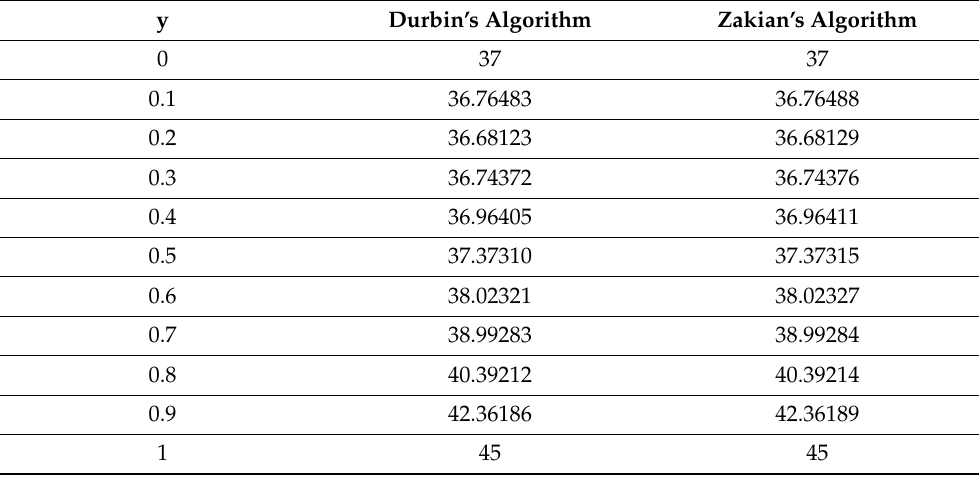
Table 1. Compression of temperature profile for Durbin’s and Zakian’s Algorithm.